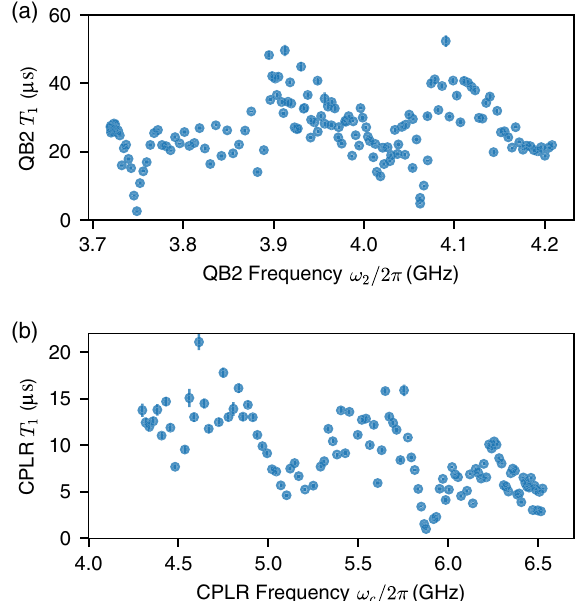
FIG. 9. (a) Energy relaxation times of QB2 as a function of its frequency ω 2 . Its T 1 drops at ω 2 = 2 π ¼ 3 . 75 and 4.07 GHz due to TLSs. (b) Energy relaxation times of CPLR as a function of its frequency ω . Its T 1 drops at ω 2 = 2 π ¼ 5 . 1 and 5.9 GHz due c to TLSs.